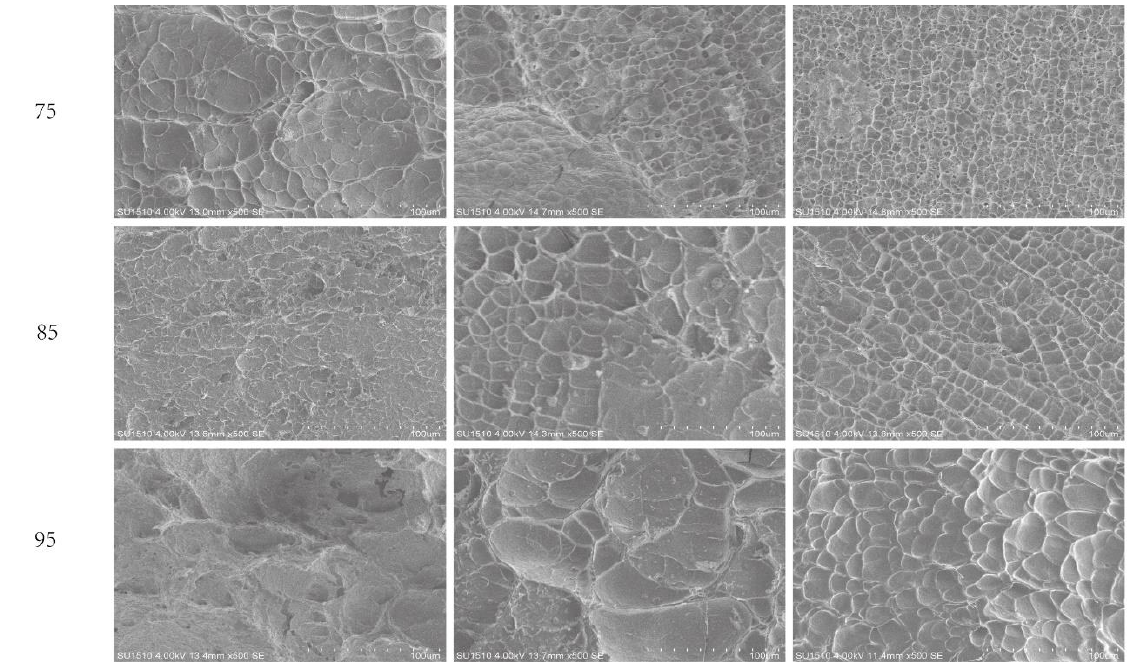
Figure 8. Scanning electron micrographs of SPI gels.